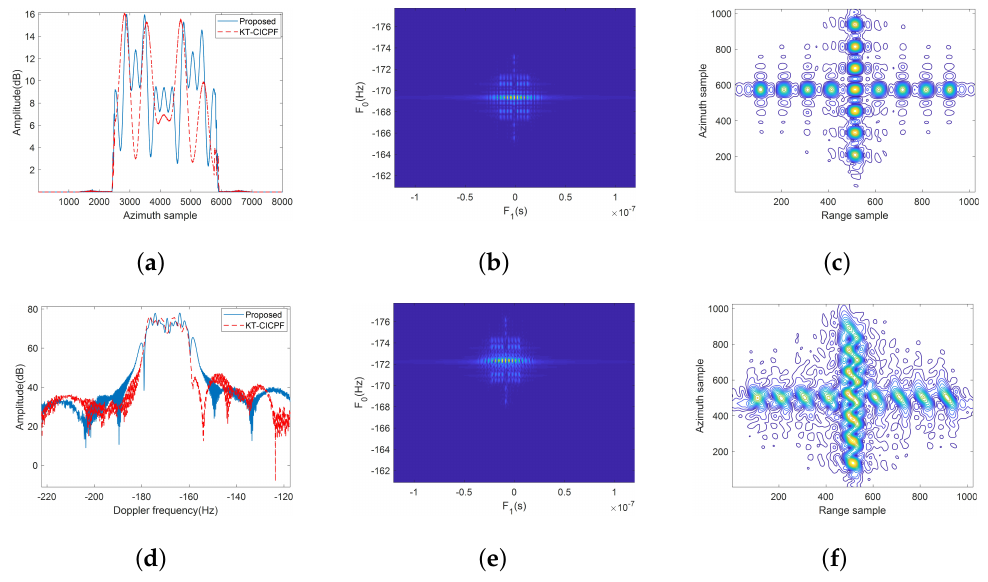
Figure 7. The focused images of T1. ( a ) Peak signal extracted by DCCF. ( b ) F 0 – F 1 parametric plane by proposed method. ( c ) Imaging by proposed method (16 × upsampling). ( d ) Spectrum of peak signal.